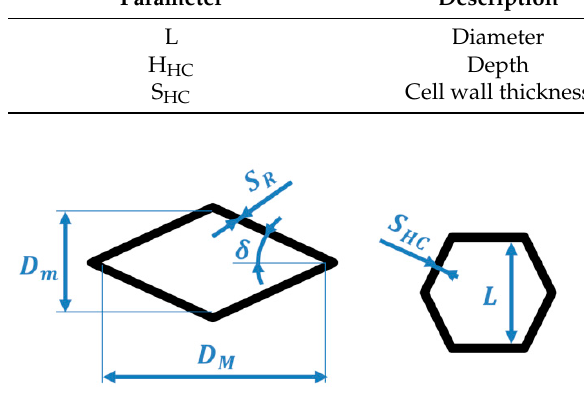
Figure 2. Rhombus ( left ) and honeycomb ( right ) cells.